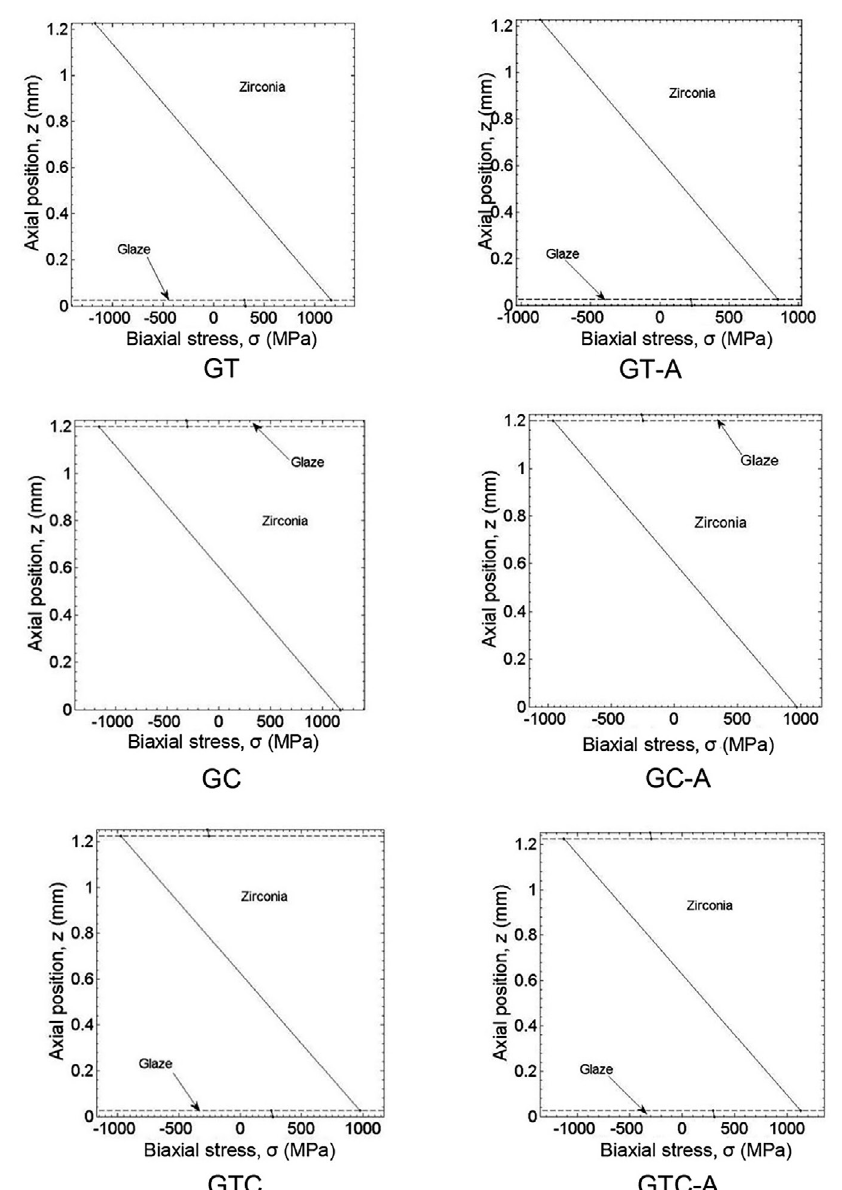
Figure 1- Stresses across the glaze and zirconia layers for the glazed groups. After mechanical ageing, a stress shift to lower strengths is seen on the zirconia surface of groups glazed on one side